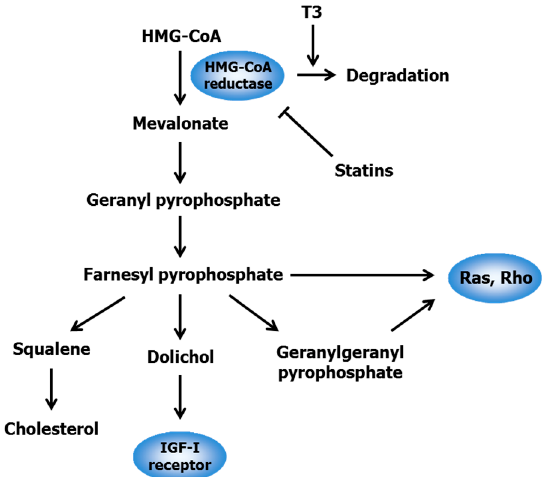
Figure 2. Mevalonate pathway and intermediates necessary for the posttranslational modification of Ras, Rho, and insulin-like growth factor I (IGF-I) receptor. T3, tocotrienol; HMG-CoA, 3-hydroxy-3-methylglutaryl-coenzyme A. Arrows and perpendicular lines indicate activation/induction and inhibition/suppression, respectively.